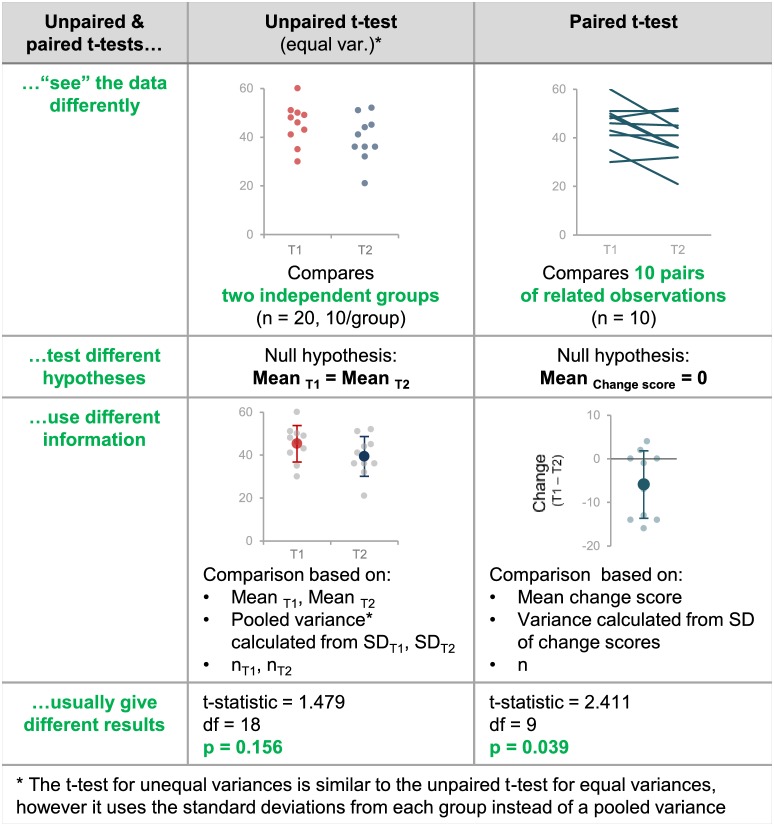
Why papers need to contain sufficient detail to confirm that the appropriate t-test was used.This figure highlights the differences between unpaired and paired t-tests by illustrating how these tests interpret the data differently, test different hypotheses, use information differently when calculating the test statistic, and give different results. If the wrong t-test is used, the result may be misleading because the test will make incorrect assumptions about the experimental design and may test the wrong hypothesis. Without the original data, it is very difficult to determine what the result should have been (see Figure 6).